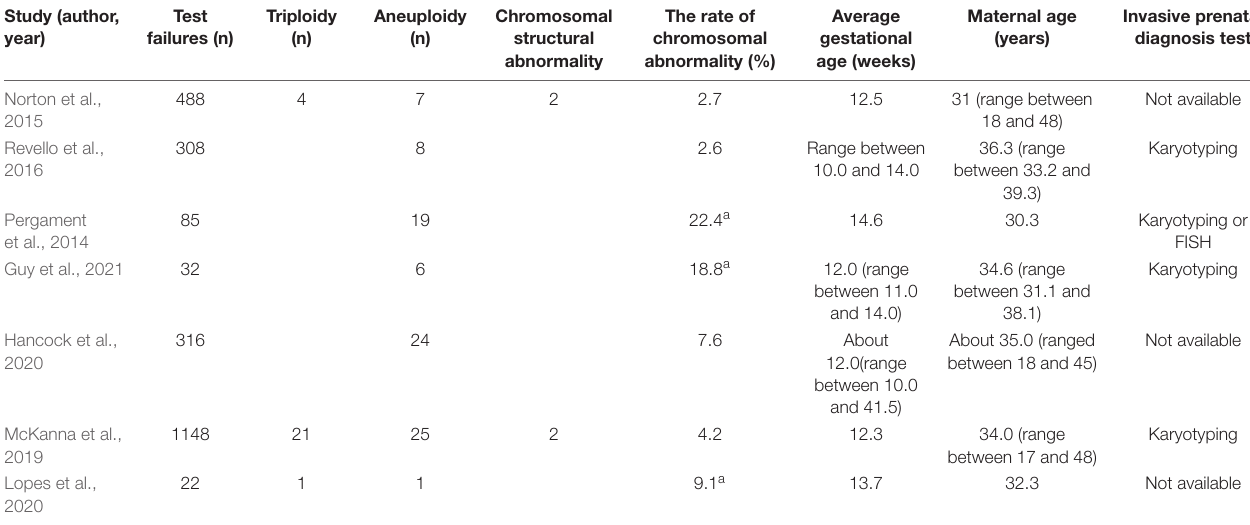
TABLE 6 | Summary of chromosomal abnormalities in cases of NIPS test failure in different studies. Study (author,